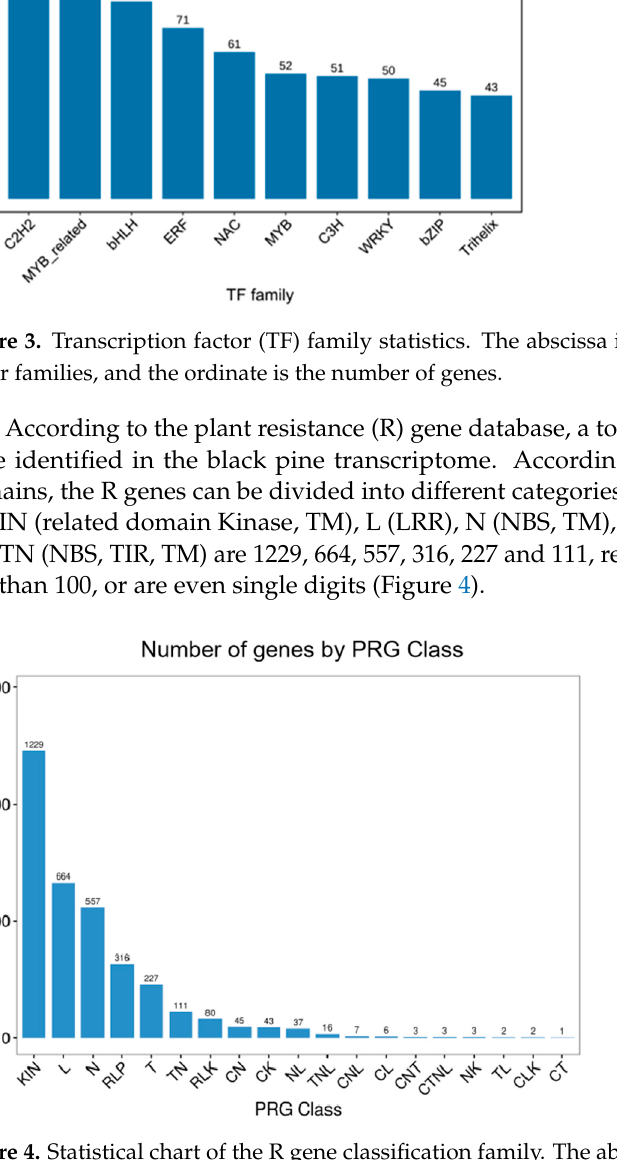
Figure 4. Statistical chart of the R gene classification family. The abscissa is the name of the R gene families, and the ordinate is the number of genes.